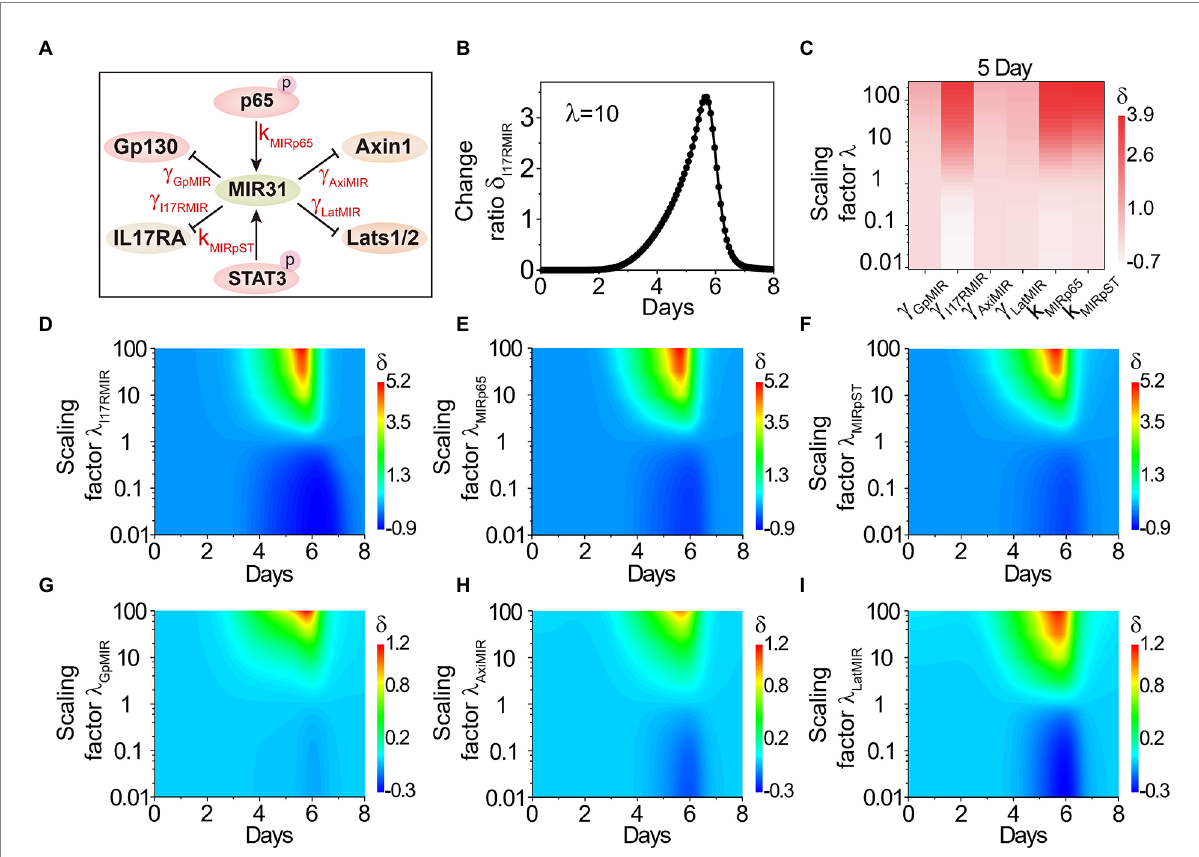
FIGURE 5 The effects of MIR31-involved reactions on the proliferative cell number. (A) The relationship between MIR31 and the related six proteins Gp130, IL17RA, Axin1, Lats1/2, p-p65 and p-STAT3. (B) The change ratio δ of the proliferative cell number varies with the scaling factor λ = 10 for the inhibition of MIR31 on IL17RA (i.e., γ I17RMIR increases with 10 times). (C) The variations δ i (t) for the inhibitions of MIR31 on Gp130, IL17RA, Axin1, and Lats1/2 ( γ GpMIR , γ I17RMIR , γ AxiMIR , γ LatMIR ), and the promotions of p-p65 and p-STAT3( k MIRp65 and k MIRpST ) on MIR31 with the scaling factor λ at 5 days of DSS treatment. (D – I) The change ratio δ i ( t ) as a function of time under continuous changes in the scaling factors λ i for all six